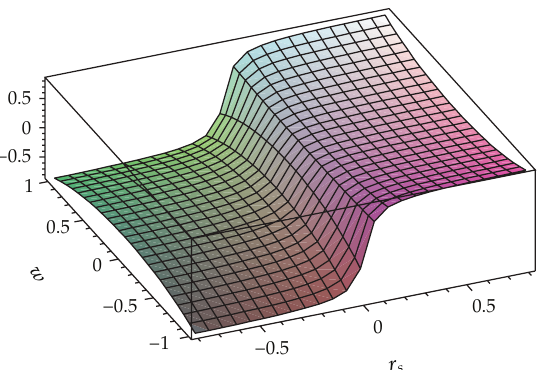
(cid:7) 0 . 025 ,α f